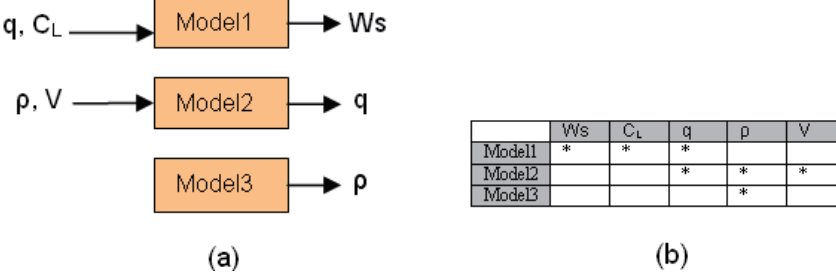
Fig. 2. (a) Models balancing the weight of aircraft with its lift, (b) Initial incidence matrix.